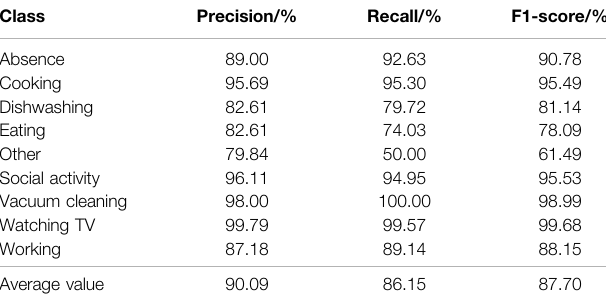
TABLE 1 | Neural network model based on the tensor network performance criteria in the test set of the development dataset. Class